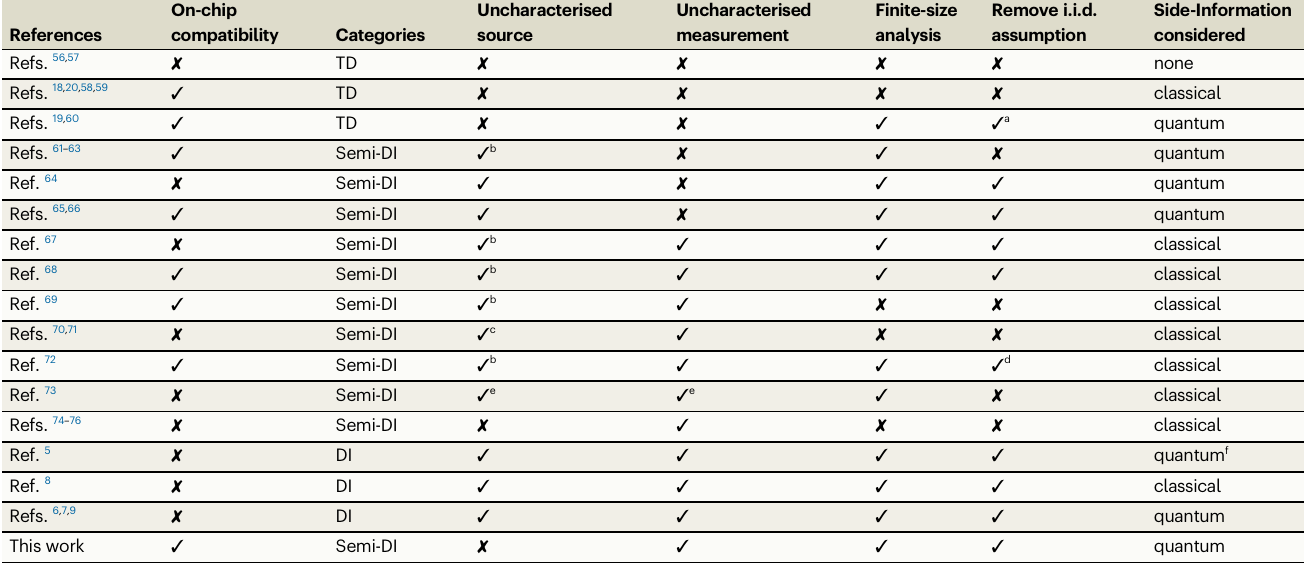
Table 1 | Features of our proposed QRNG protocol as compared to the features of existing protocols On-chip